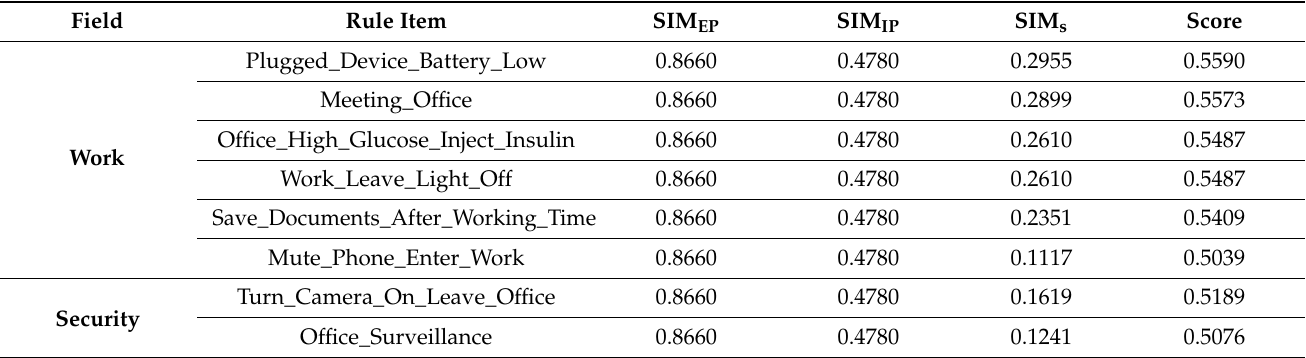
Table 4. List of recommended rules with first preference configuration and context (home).